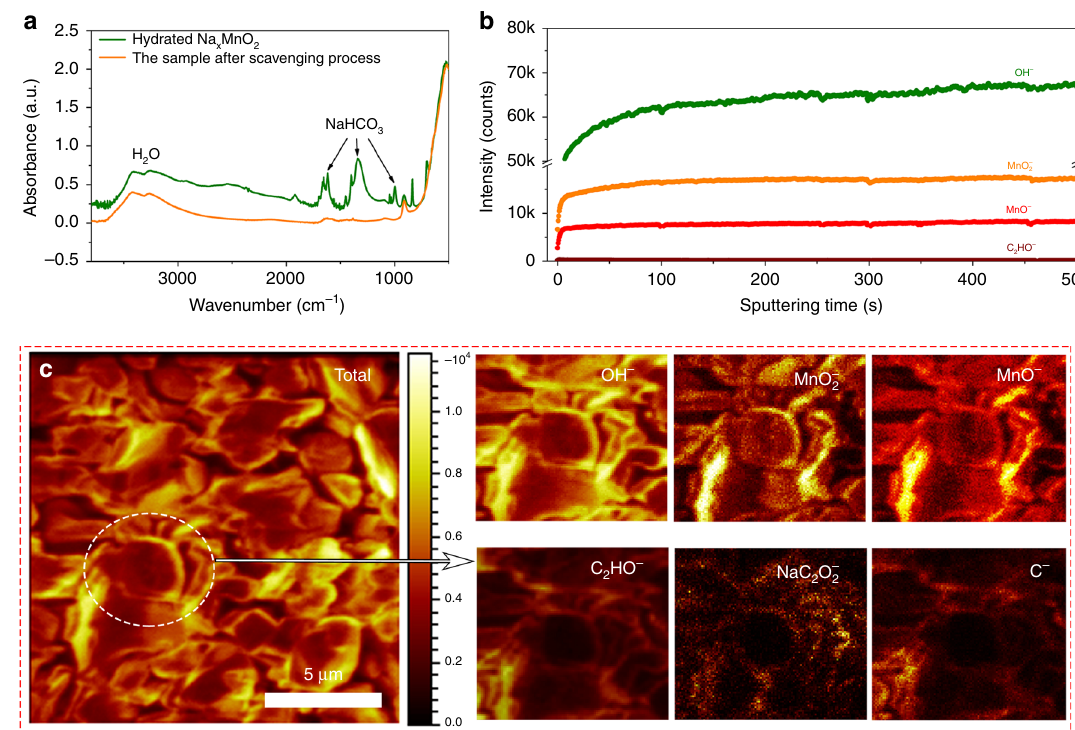
Fig. 3 TOF-SIMS results of the hydrated Na 0.67 MnO 2 sample. a the comparison of FTIR spectra of the hydrated Na 0.67 MnO 2 and hydrated Na 0.67 MnO 2 after the scavenging process, indicating that after scavenging, most of the sodium (bi)carbonate impurities was removed. b TOP-SIMS spectra of OH − , MnO − , MnO 2 − , and C 2 HO − secondary ion fragments over 500 s Cs + sputtering along the depth pro fi le of the sample after scavenging processes. c TOF- SIMS chemical mapping of the hydrated Na 0.67 MnO 2 after the scavenging process, showing the distribution of OH − , MnO 2 − , MnO − , C 2 HO − , NaC 2 O 2 − , and C − secondary ions.